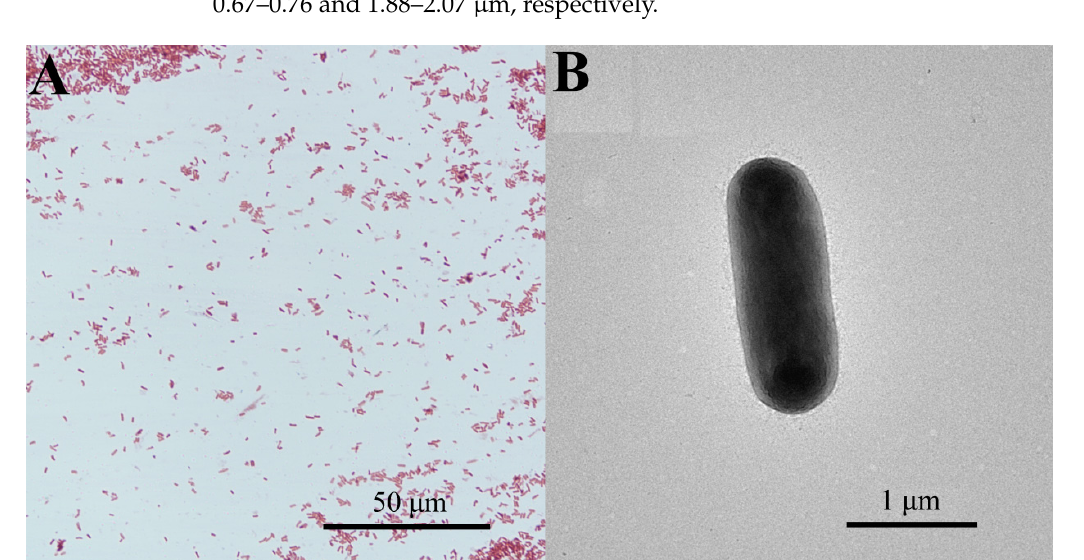
Figure 1. Macrobrachium rosenbergii infected with Citrobacter freundii showing typical signs of WBD under the carapace (red arrow).